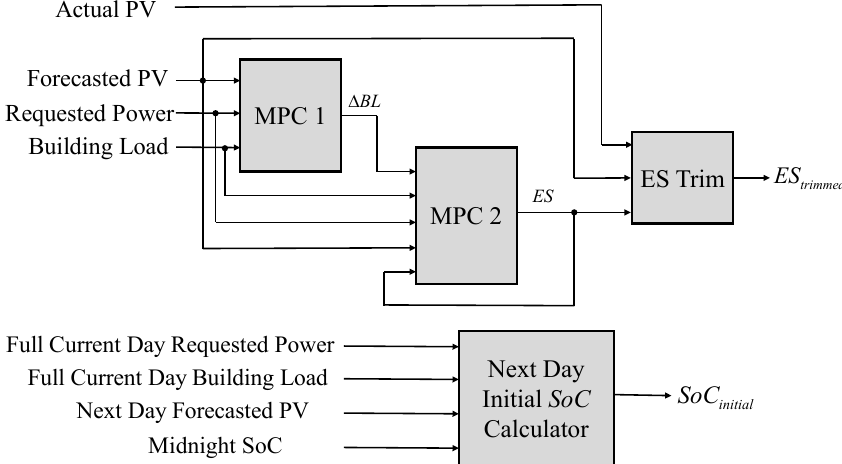
Figure 3. MPC local control